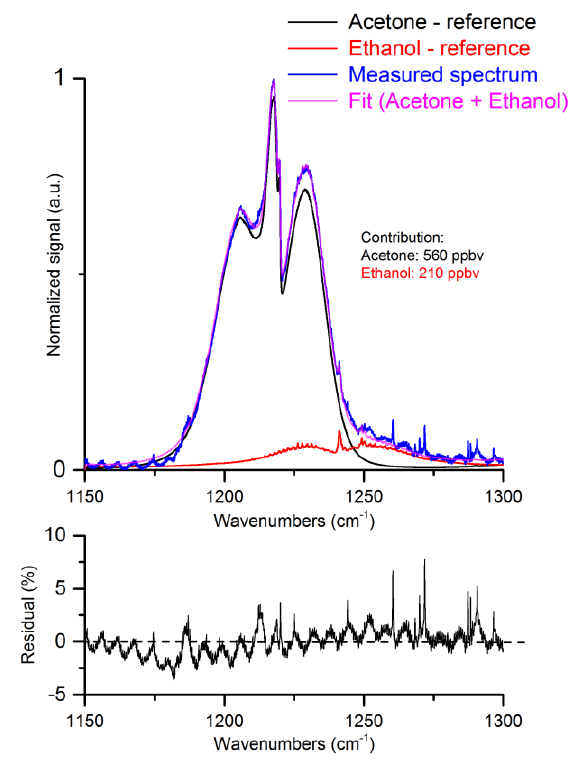
Figure 4. Typical measured absorption spectrum of a breath sample consisting of a combined spectrum of acetone, ethanol and water. The recorded spectrum is fitted with a linear combination of two reference spectra of acetone and ethanol. After minimizing the residual, the relative contribution of both gases contained in the sample is known. The concentration of both gases present in the sample can be then calculated as the reference gases (acetone and ethanol in N 2 ) with known concentrations have been measured prior the experiment.